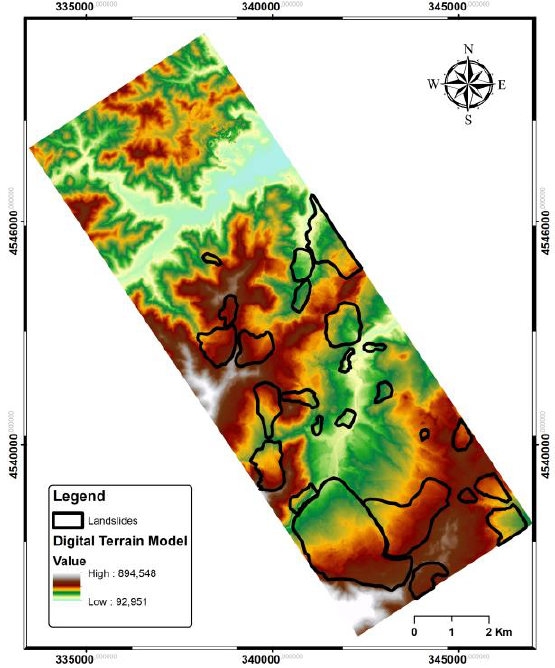
Figure 5. Landslide inventory and the